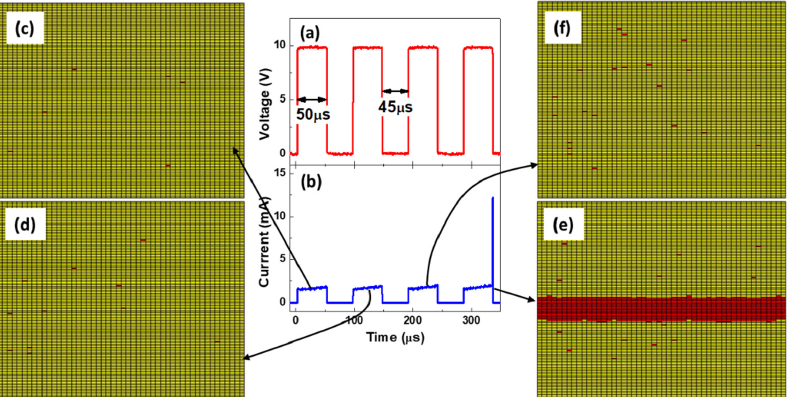
Figure 6. ( a ) Applied voltage pulse train and ( b ) measured device current for t on = 50 µs and t off = 45; ( b – f ) Simulated metallic domain distribution during each of the pulses (yellow: insulating domains; red: metallic domains).